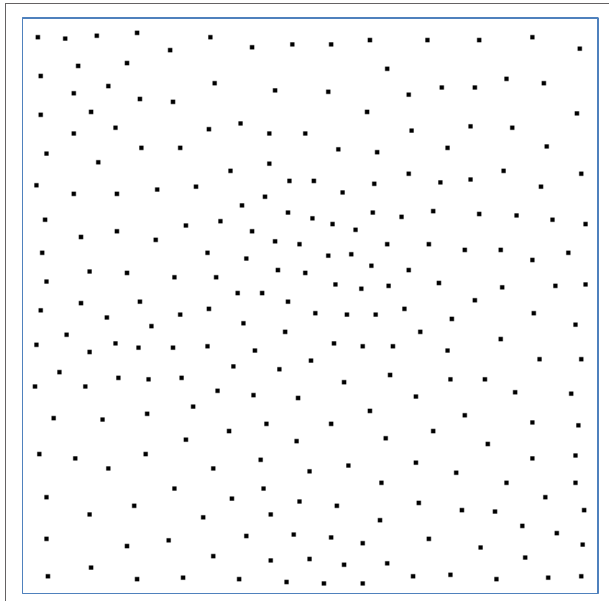
FIgURe 7 | Random distribution of markers used as a sampling pattern in this study.